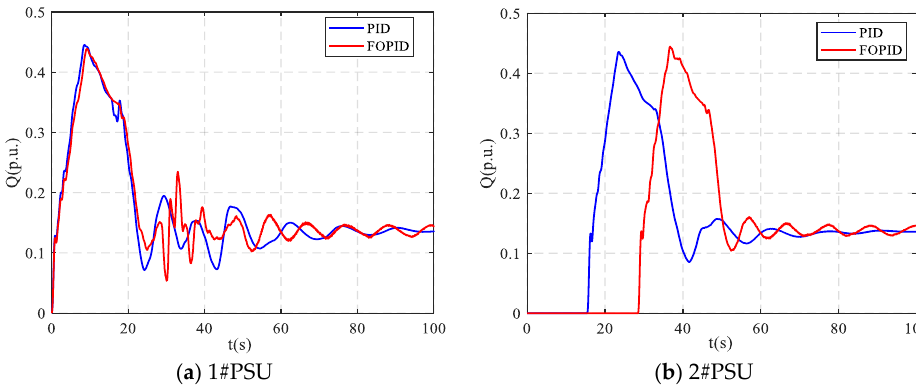
Figure 14. The rotational speed dynamic curves of the two PSUs.